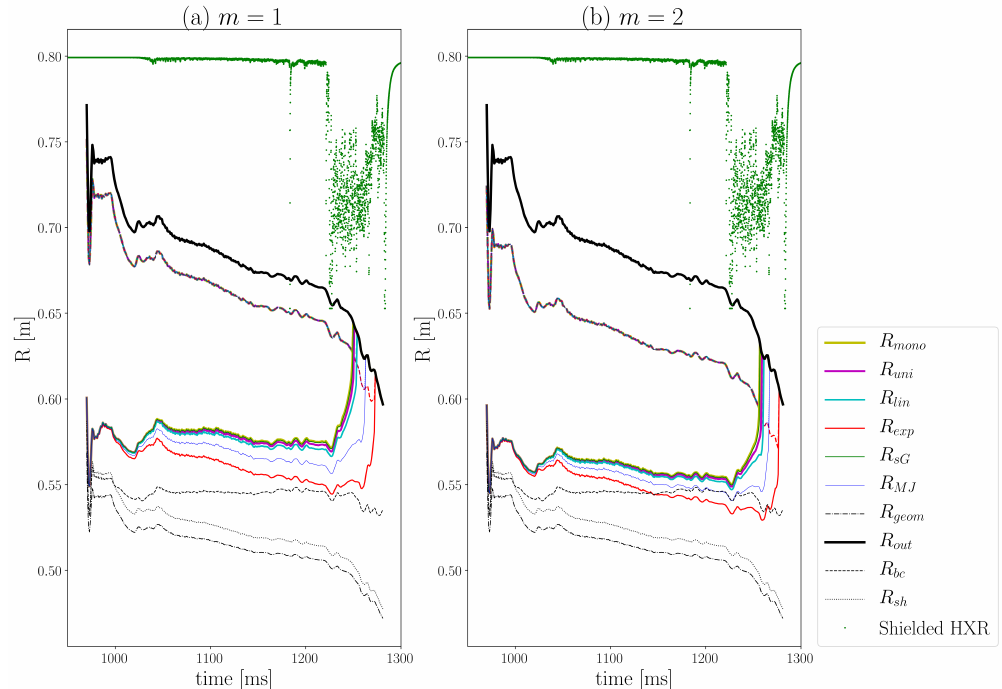
Figure 5. Time traces for lower ρ min (solid colored lines) and upper ρ max (dashed coinciding colored lines) limits of RE major radii for all six REDFs are presented for discharge #7298. For orientation, major radius of plasma geometrical center R geom (black dash-dotted line), outer plasma major radius R out (black solid line), plasma current barycenter R bc (black dashed line) and theoretical bulk plasma barycenter from Shafranov shift R sh (black dotted line) are added. Beside all major radii, the Shielded HXR signal (green points) is presented. Figure is plotted for two of current profile factor m values: ( a ) m = 1; and ( b ) m =